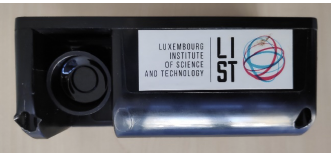
Figure 7. Brighterbins ultrasonic sensor (L=130mm, W=70mm, H=53mm).